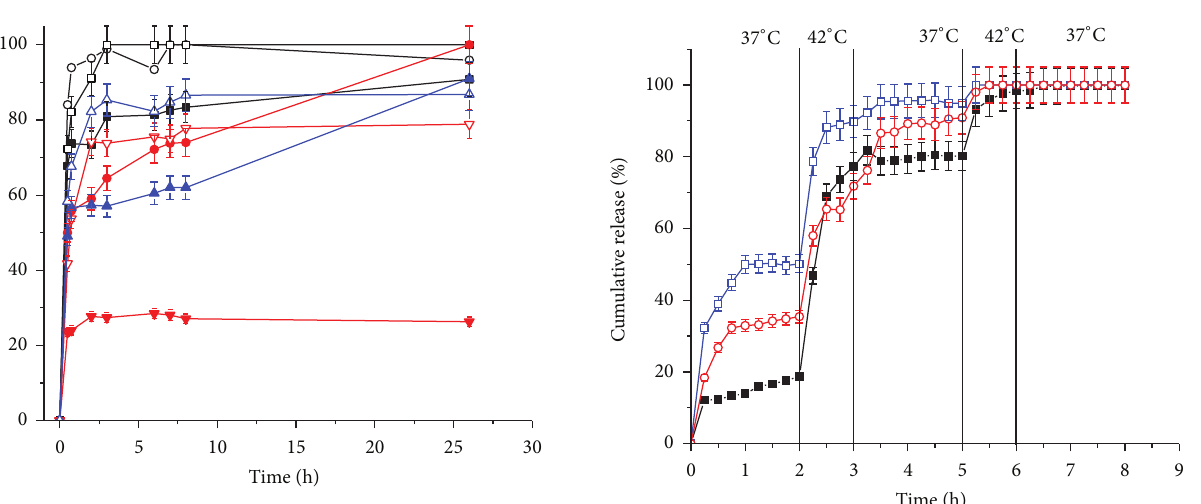
Figure 6: AFM topography images of star polymers: (a) [poly(NIPAAm- co -4MBA 5 EGDMA 10 .